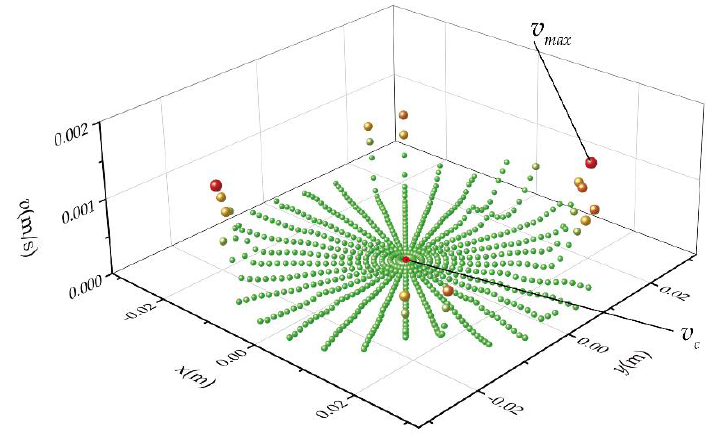
Figure 12. Scanning results diagram.